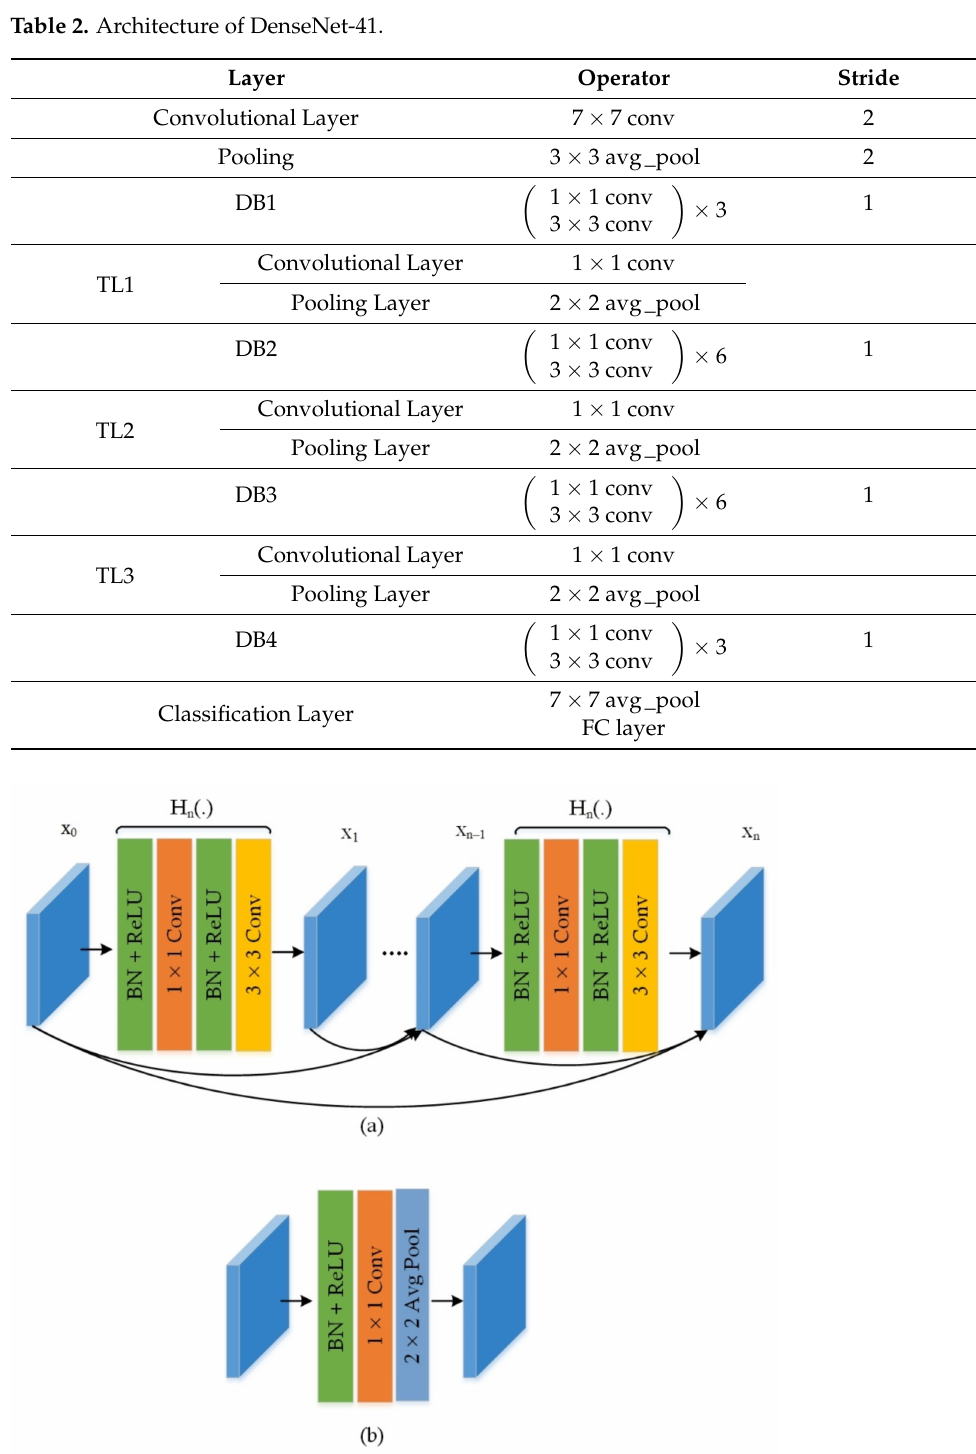
Figure 3. The structure of ( a ) Dense Block and ( b ) Transition